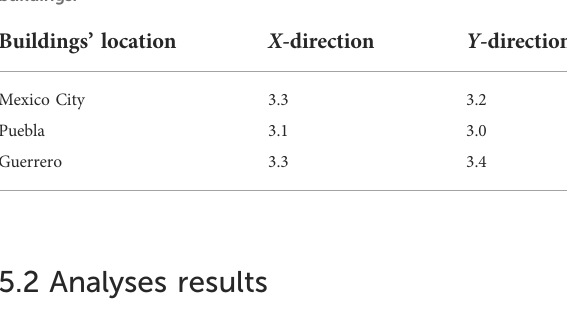
TABLE 3 Calculated global ductility capacity ( μ C ) for the designed RC